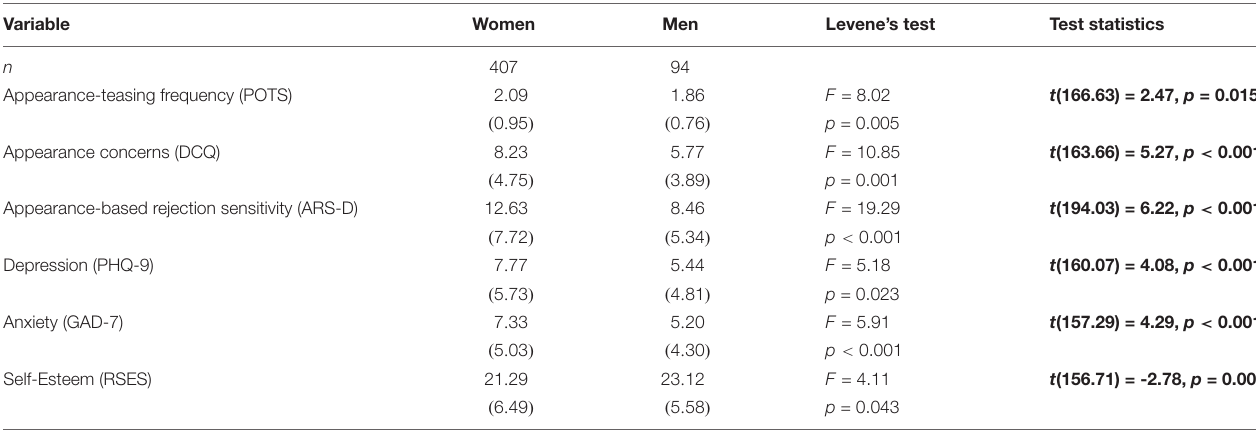
TABLE 2 | Gender differences in teasing frequency, body image, and mental health (mean, standard deviations, and test statistics).